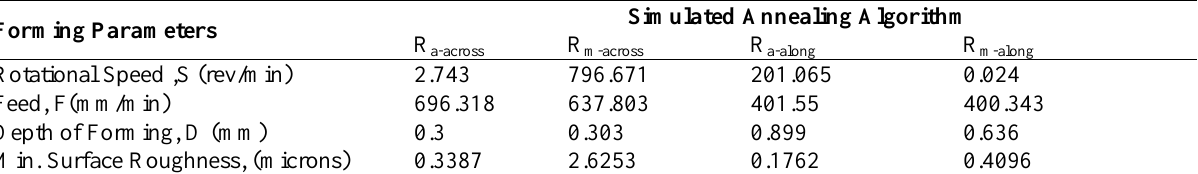
The input parameters with respect to output values of simulated annealing algorithms. “ Forming Parameters